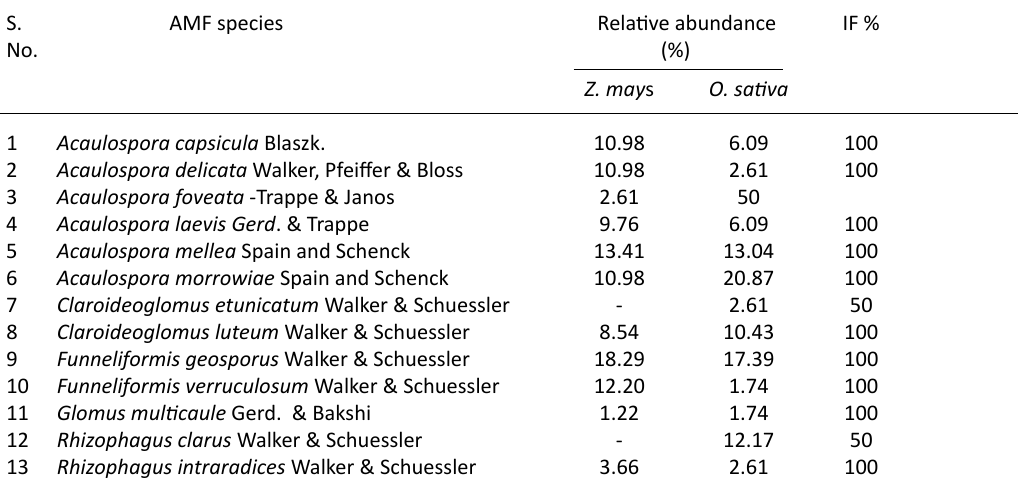
Table 1. AMF species isolated from trap cultures (2 years abandoned site derived inoculum) with their relative abundance and isolation frequency (IF) using Z. may s and O. sativa as trap plants S.